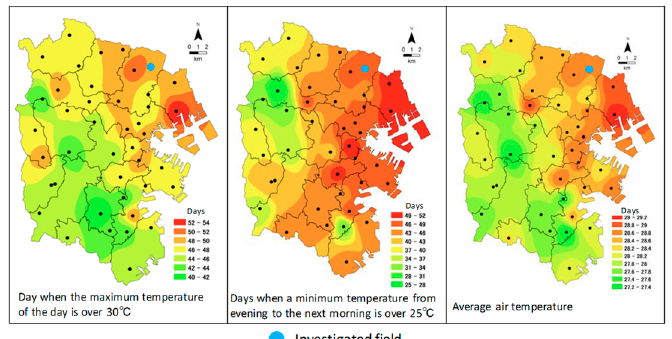
Figure 4. Distribution of day for various temperatures in Yokohama (July and August 2018) [27].